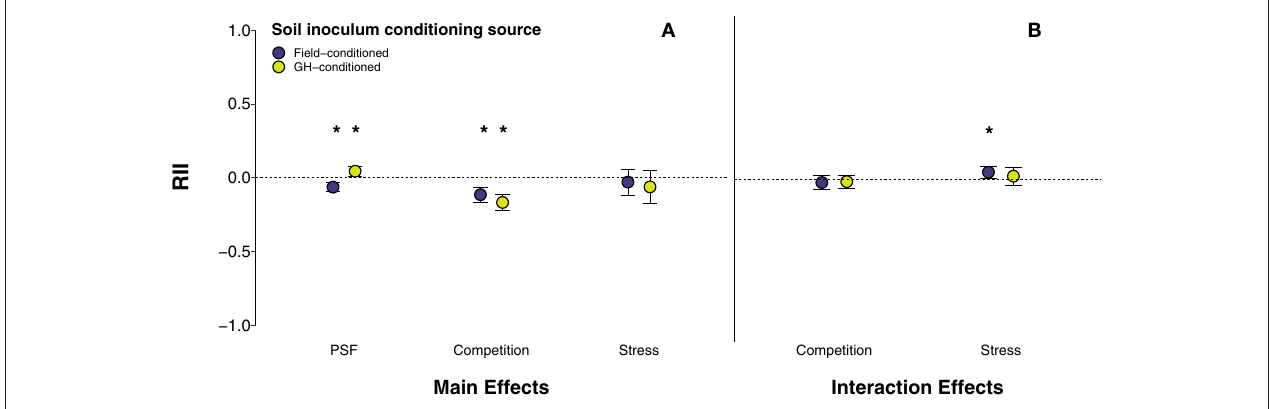
FIGURE 4 | (A) Main effects of PSF, competition, stress, and disturbance and (B) interaction effects of PSF x competition and PSF x stress between field-conditioned and greenhouse-conditioned soil inoculum. Interaction effects of PSF x competition and PSF x stress are averaged across soil manipulations (live/sterile, away/home, untreated/fungicide) and across competition and stress manipulations. Error bars represent lower and upper bounds of the confidence intervals. Asterisks indicate effect sizes significantly different from zero.